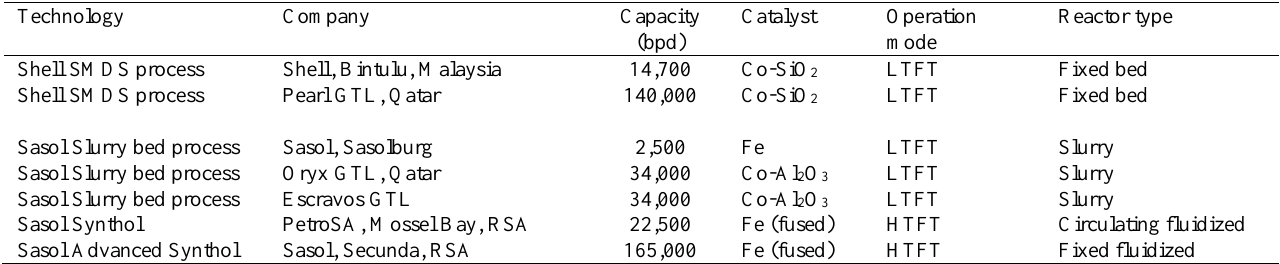
Table 2: Current FT-based integrated GTL plants Technology